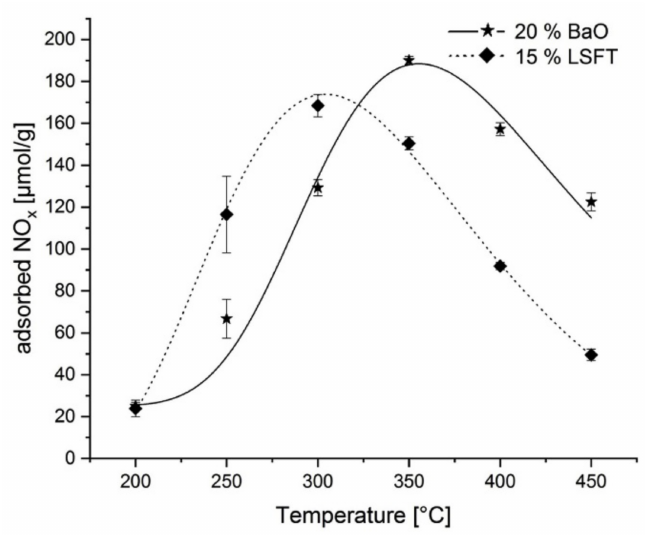
Figure 2. Comparison of the temperature-dependent NO x storage capacities of infiltration composite 15 wt.% La 0.5 Sr 0.5 Fe 1 − x Ti x O 3- δ loading ( (cid:7) ) and a conventional Pt/BaO/Al 2 O 3 (20% BaO)